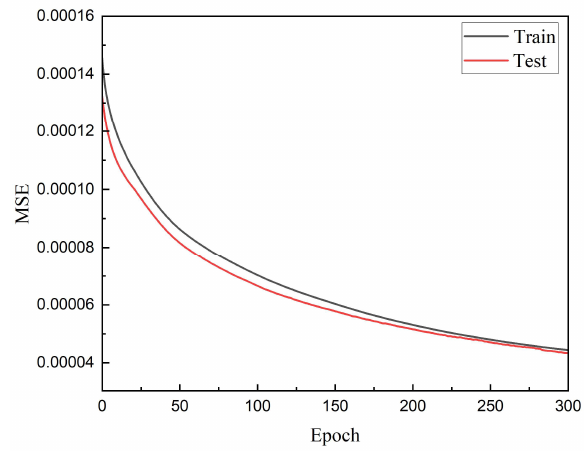
Figure 6. Training error and test error of level-2 of hierarchical optimization. After the training, the spectral transmittance curve of the filter is obtained by invoking the FC layer parameter of the first FC layer without offset in the optimal network. As can be seen from Figure 7, the spectral transmittance curve of the filter is smooth, and it can be preliminarily judged that it can be reverse-designed and produced.